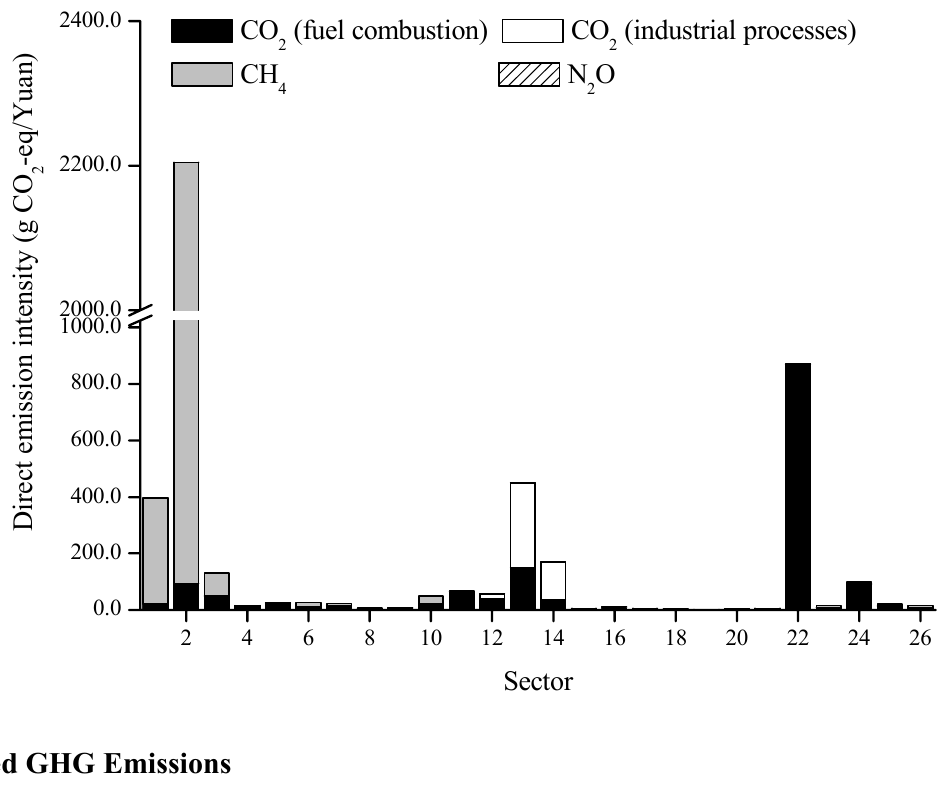
Figure 1. Direct GHG emission intensities by emission